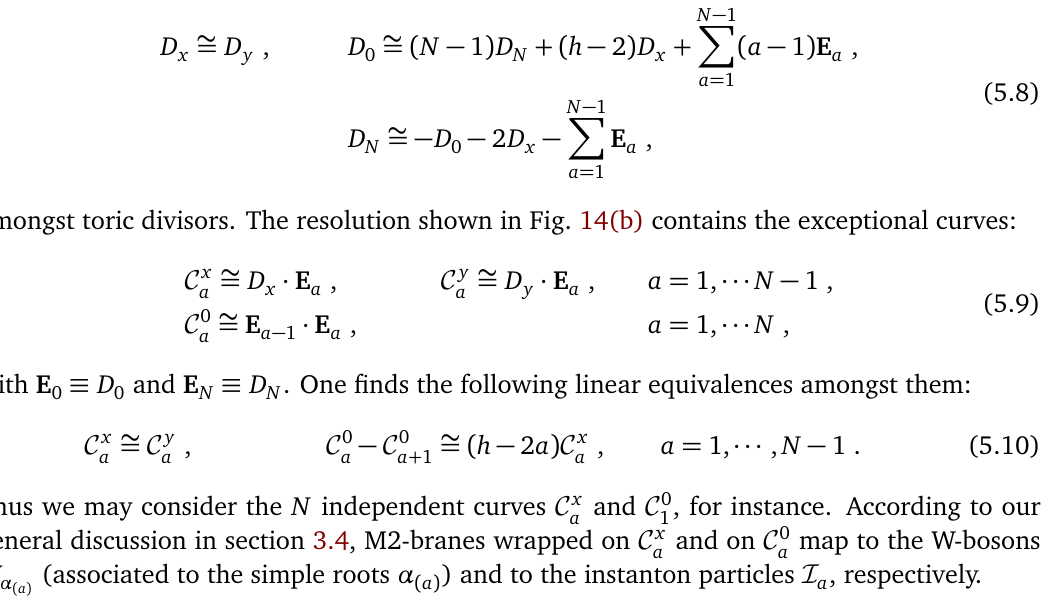
toric singularities.” Upon vertical reduction, the k , SU ( 4 ) , SU ( 4 ) and SU ( 4 ) , 1 0 1 3